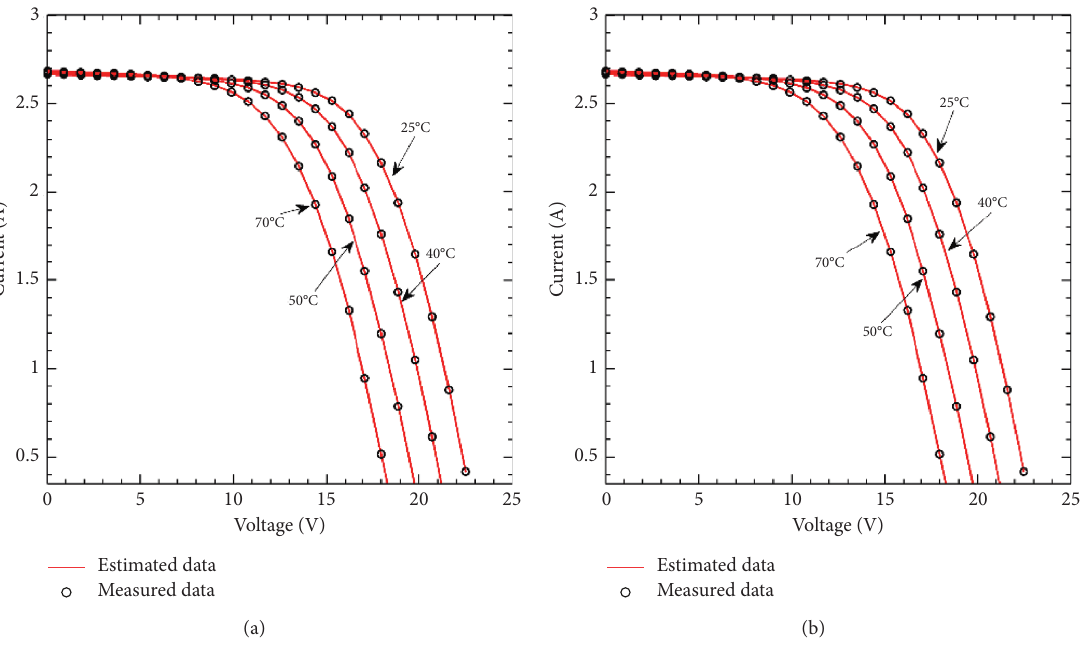
Figure 14: I-VC of (a) SDM and (b) DDM for thin-film ST40 at different